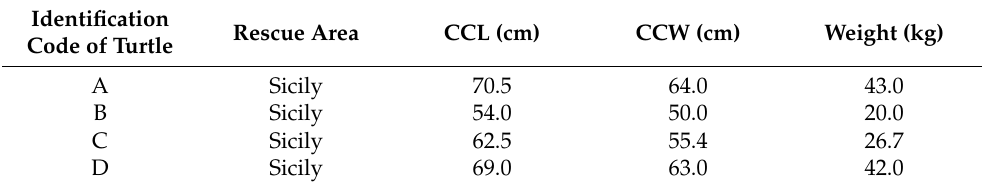
Table 2. Identification code of turtles investigated in this paper, along with their corresponding rescue areas, curved carapace length (CCL), curved carapace width (CCW), and weight.